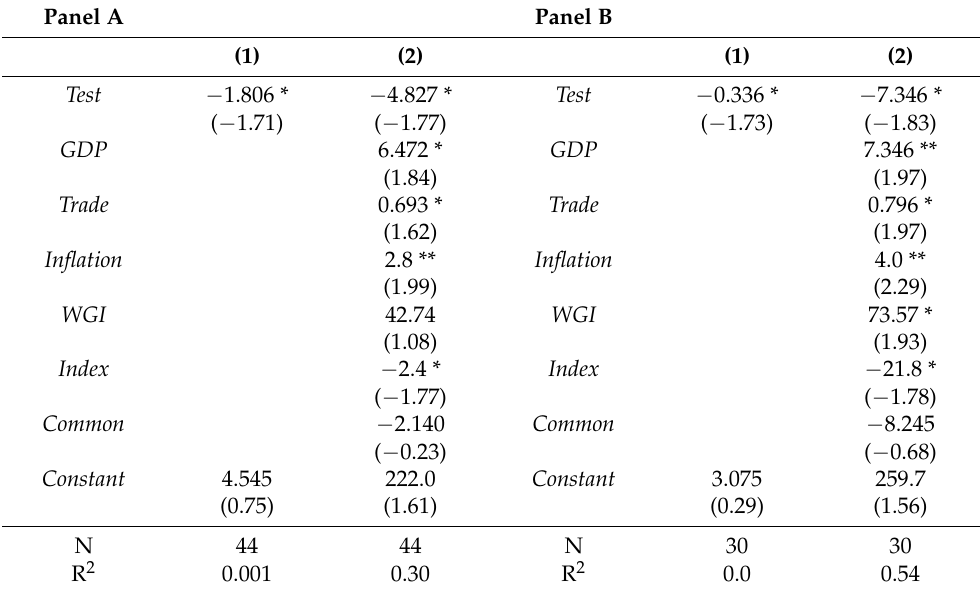
Table 6. This table shows the results of a difference-in-difference test using an OLS regression on the cash paid. In Panel A, the dependent variable is [diff]; the difference in the mean percentage of cash paid in a deal before and after 2007 for each of the countries in the sample. The main independent variable is [test], an indicator variable that equals 1 if social media became popular in that country in 2007 and 0 otherwise. Macro-economic control variables have been included in all models. Panel B shows the results of the same test performed, where late adopters are defined as countries where social media became popular after 2009